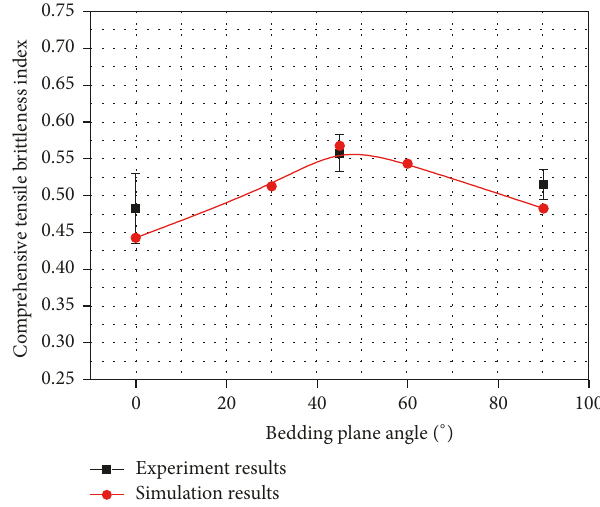
Figure 13: Influence of anisotropy on shale